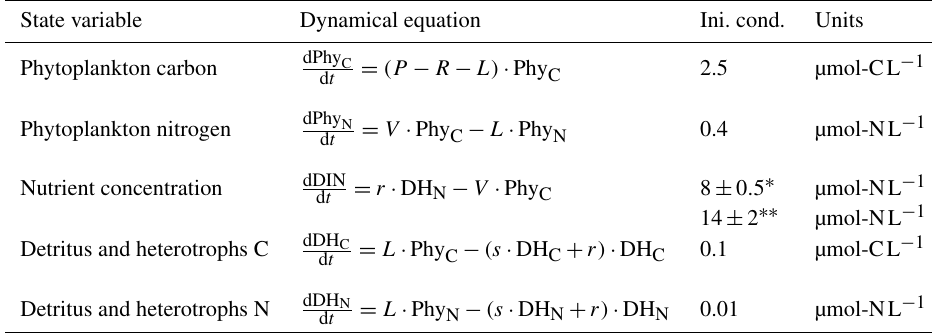
Table 1. States variables and their dynamics.